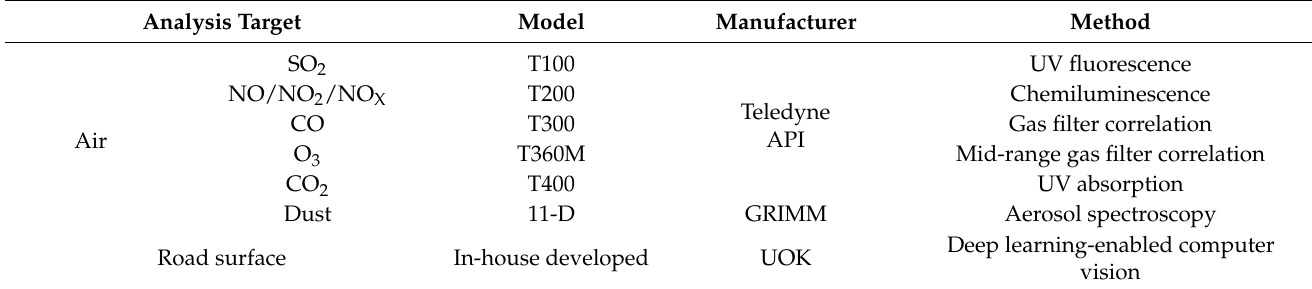
Figure 3. Developed vehicle and equipped environmental monitoring instruments. Table 5. Specification of instruments used for environmental